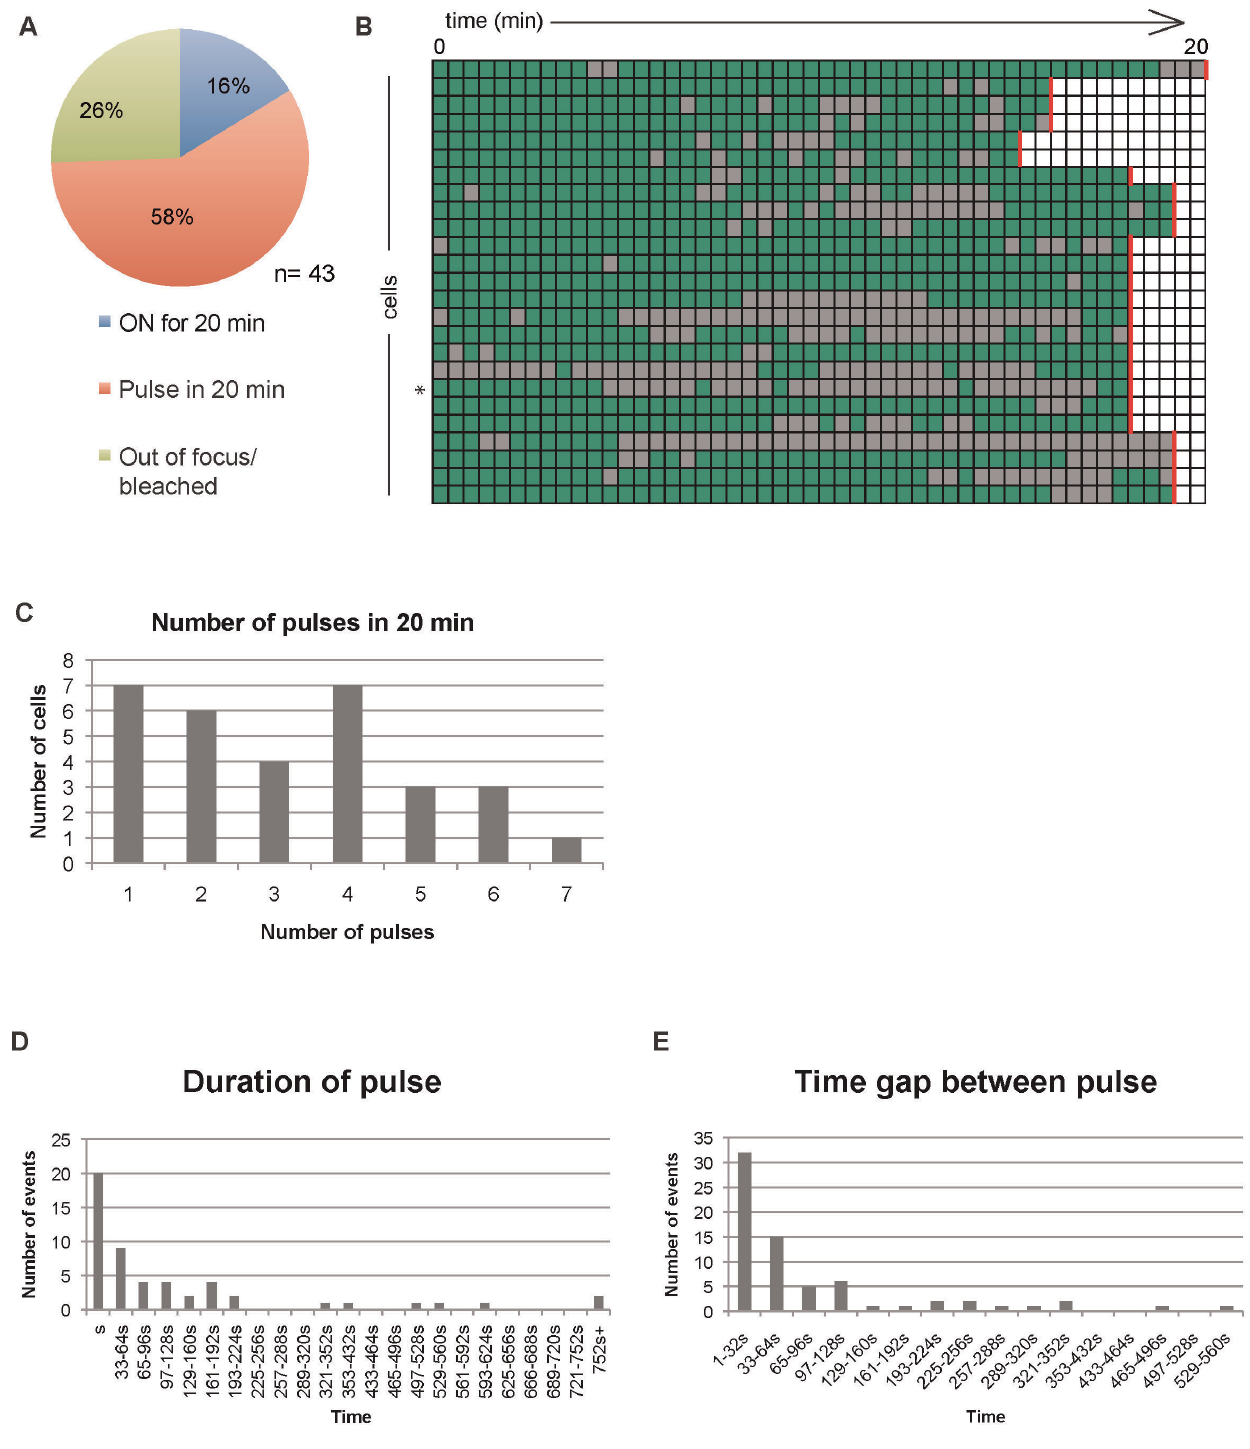
Figure 6. Dynamics of transcriptional pulsing in Clone B6. A. Transcriptional activity of cells possessing an EGFP foci at the start of live imaging. B. Summary of transcriptional dynamics displayed by all pulsing cells in Clone B6. Green squares indicate timepoints with detectable transcription foci and gray squares represent timepoints without transcription foci. Each square represent 25–32 seconds depending on the cell examined and red line denotes 20 minutes of imaging. An asterisk marks the cell shown in 5A. C. Number of pulses detected in 20 minutes in all cells in Clone B6. One pulse represents a cell that is expressed continuously for 20 minutes. D. Distribution of duration of gene activity of Clone B6. E. Distribution of time gaps between transcriptional pulses of Clone B6.